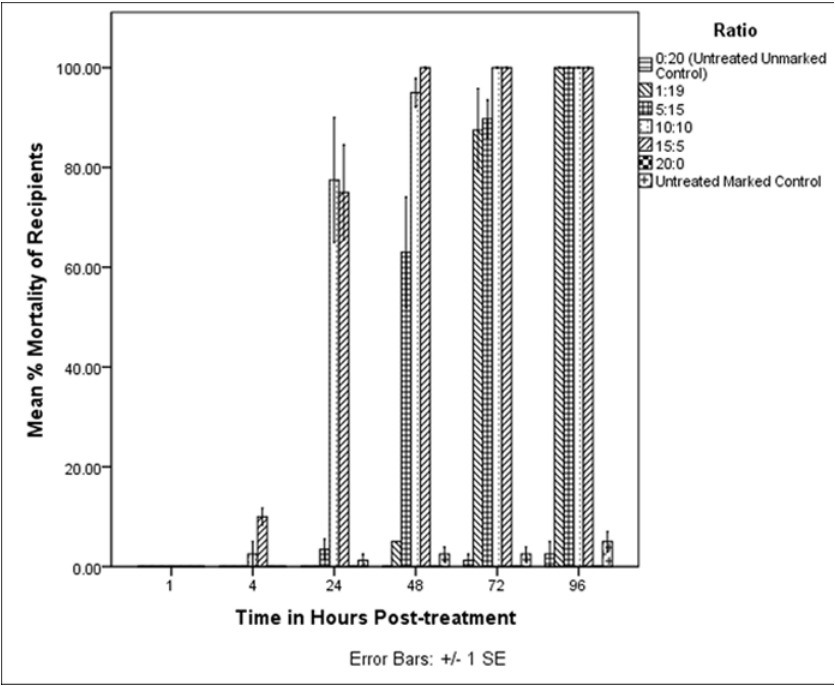
Fig. 7. Mean % mortality of recipient populations in different cohorts of donor:recipient Coptotermes formosanus termites through time when exposed for 30 minutes to soil treated with Termidor ® HE at 0.12%